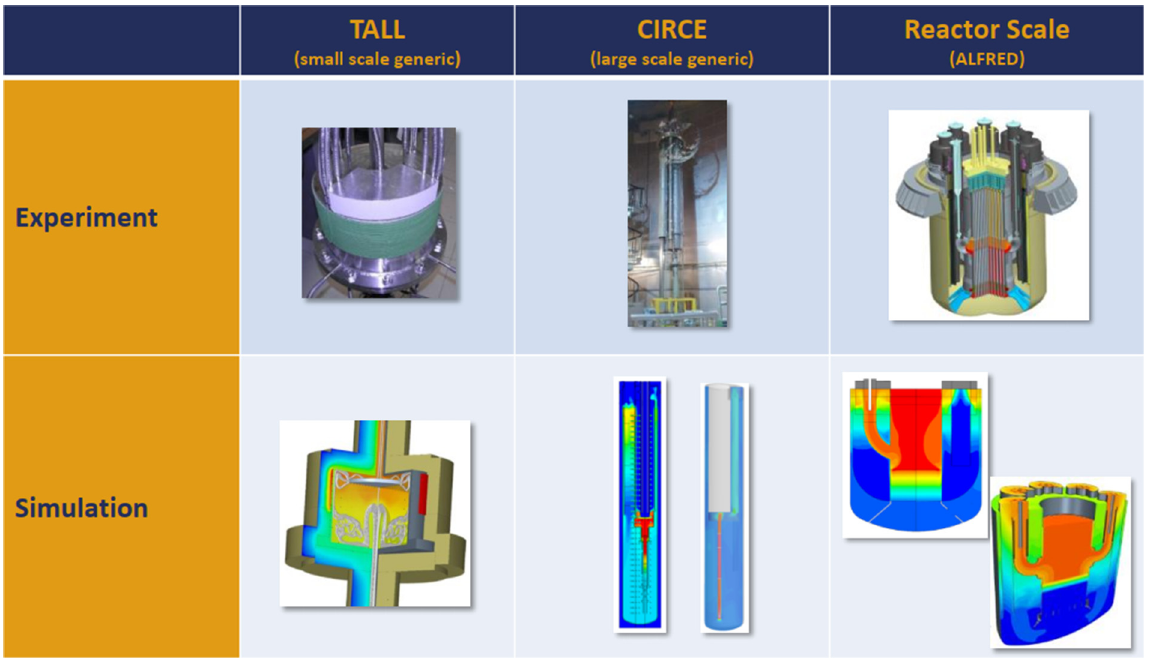
Fig. 5. Overview of experimental and numerical pool thermal hydraulic activities.